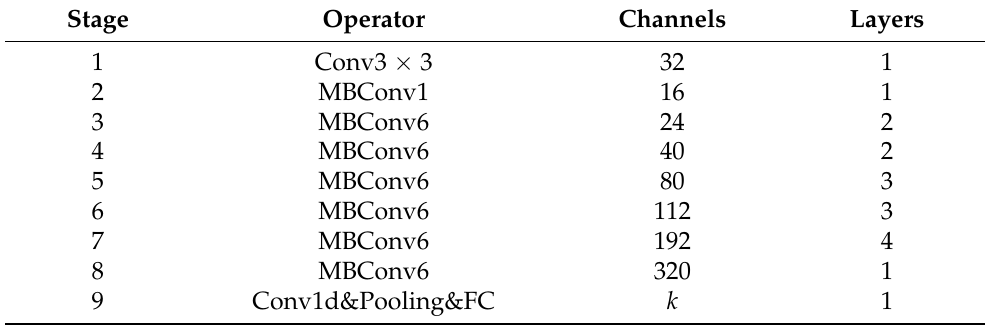
Table 1. EfficientNet-B0 network structure in this paper, MBConv is Mobile Inverted Bottleneck Convolution